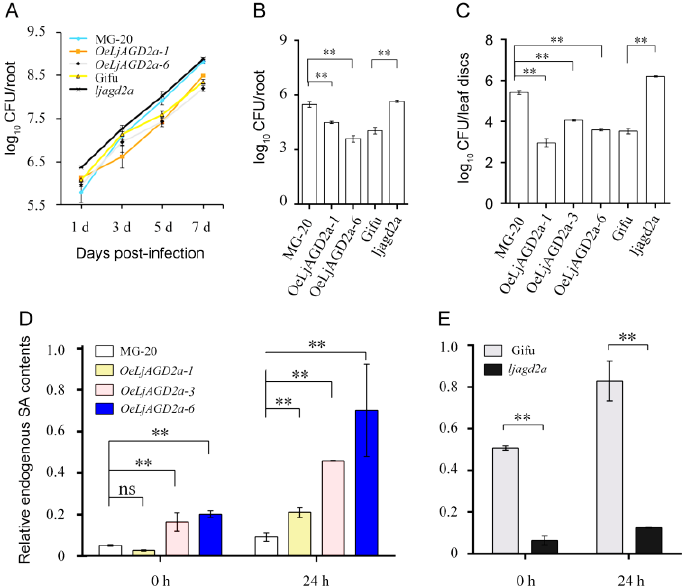
Figure 6. LjAGD2a promotes disease resistance in L japonicus . ( A ) Growth curves of R. solanacearum strains on the roots of transgenic ljagd2a lines, mutant lines and their respective wildtypes (MG-20 and Gifu129). Plants were infected with R. solanacearum at indicated time points. R. solanacearum grew more rapidly in ljagd2a plants than in their wildtype. In the first 3 days of pathogen infection, there was no significant difference in growth of R. solanacearum between OeLjAGD2a and MG-20 plants, but the pathogen’s growth was inhibited in OeLjAGD2a plants at 5 dpi. ( B ) Numbers of colony forming units (CFU) showing the disease susceptibility of roots. The indicated genotypes were inoculated with R. solanacearum by including the bacterium at a density equivalent to OD 600 = 0.0002 in the growth medium and assaying the bacteria at 5 dpi. ( C ) Numbers of colony forming units (CFU) showing the disease susceptibility of detached leaves. Overexpression of LjAGD2a suppressed and its insertion mutation promoted growth of the pathogen. Detached leaves from 8-week-old plants were infected with R. solanacearum . ( D ) Total SA levels in OeLjAGD2a plants 0 and 24 h post-infection. ( E ) Total SA levels in ljagd2a mutants 0 and 24 h post-infection. Overexpression of LjAGD2a increased and its mutation reduced total SA levels after pathogen infection. 6 – 10 roots/leaves were used in each replicate and Error bars represent the SD of three replicates per genotype in ( A – C ). In experiments providing results shown in ( D , E ) each sample had three to four replicates and error bars represent the SD of 3 – 4 replicates. In A – E, ** indicates p < 0.01 according to the Duncan test.